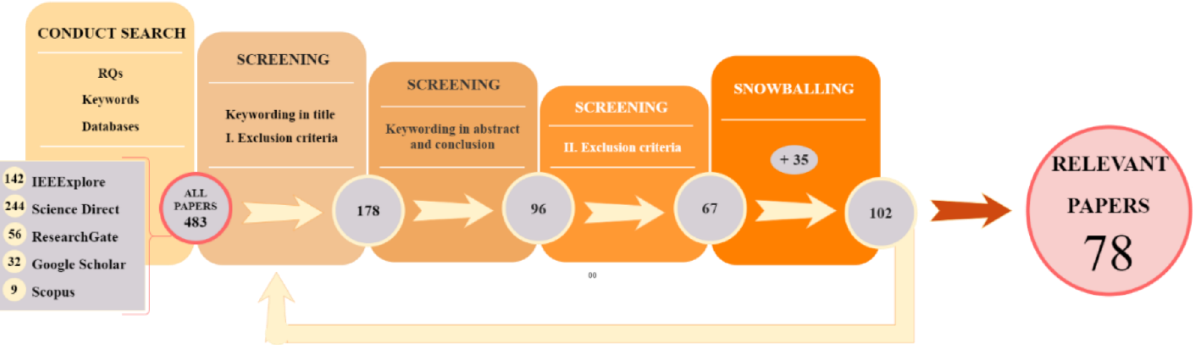
Figure 5. A breakdown of the screening